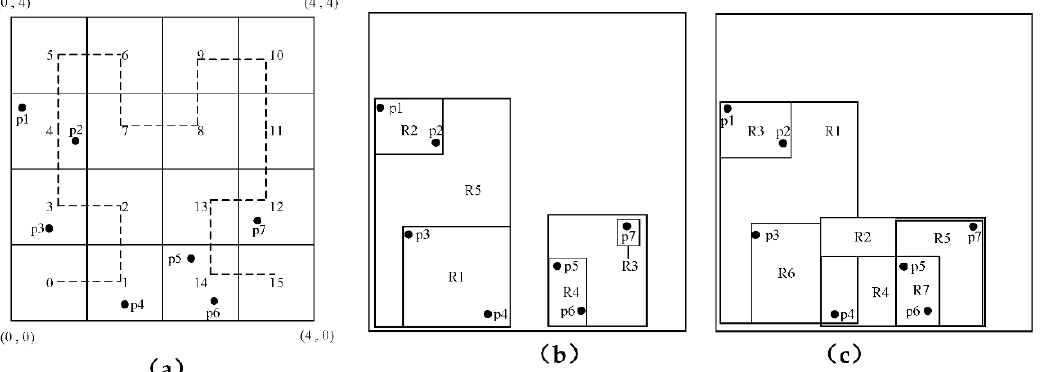
Figure 4. Hilbert R-tree and R-tree comparison: ( a ) Hilbert curve in spatial coordinates; ( b ) MBR of the Hilbert R-tree; ( c ) MBR of the R-tree.